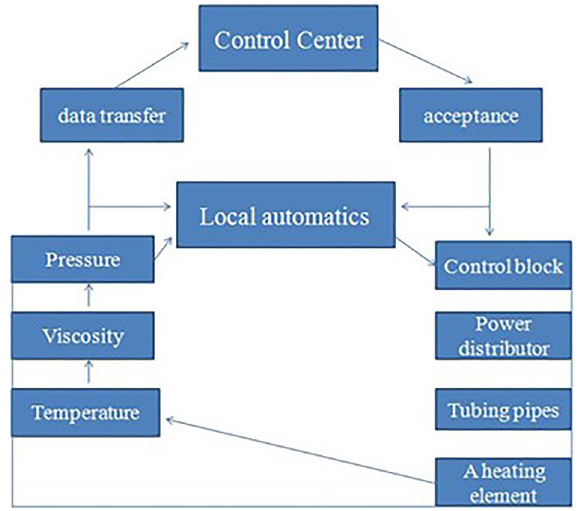
Figure 2. Scheme of information flows of an oil well with installed heating